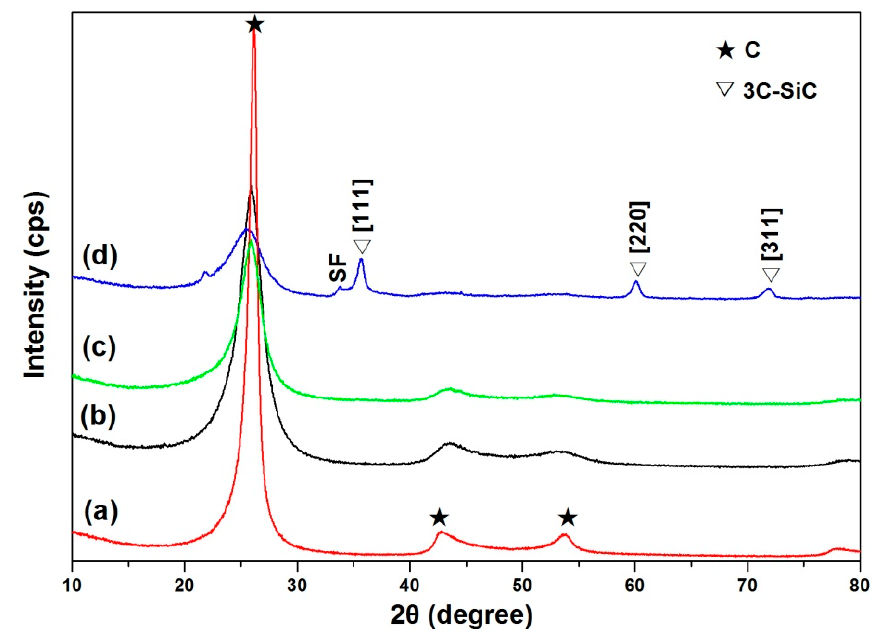
Figure 3. X ‐ ray diffraction patterns for composites at different stages: ( a ) The carbon felt, ( b ) xerogel, ( c ) SiOC-C/C preform, and ( d ) SiCNW-C/C felt/silica xerogel, ( c ) SiOC ‐ C/C preform, and ( d ) SiCNW ‐ C/C perform.